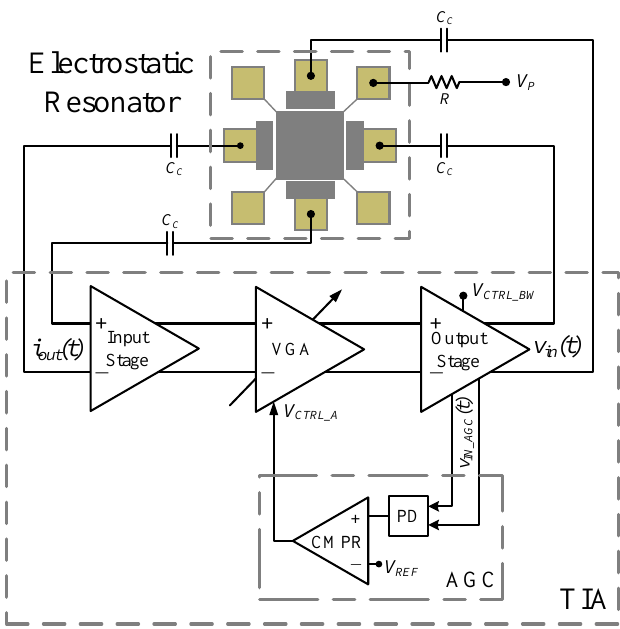
Figure 3. MEMS-based oscillator functional diagram.